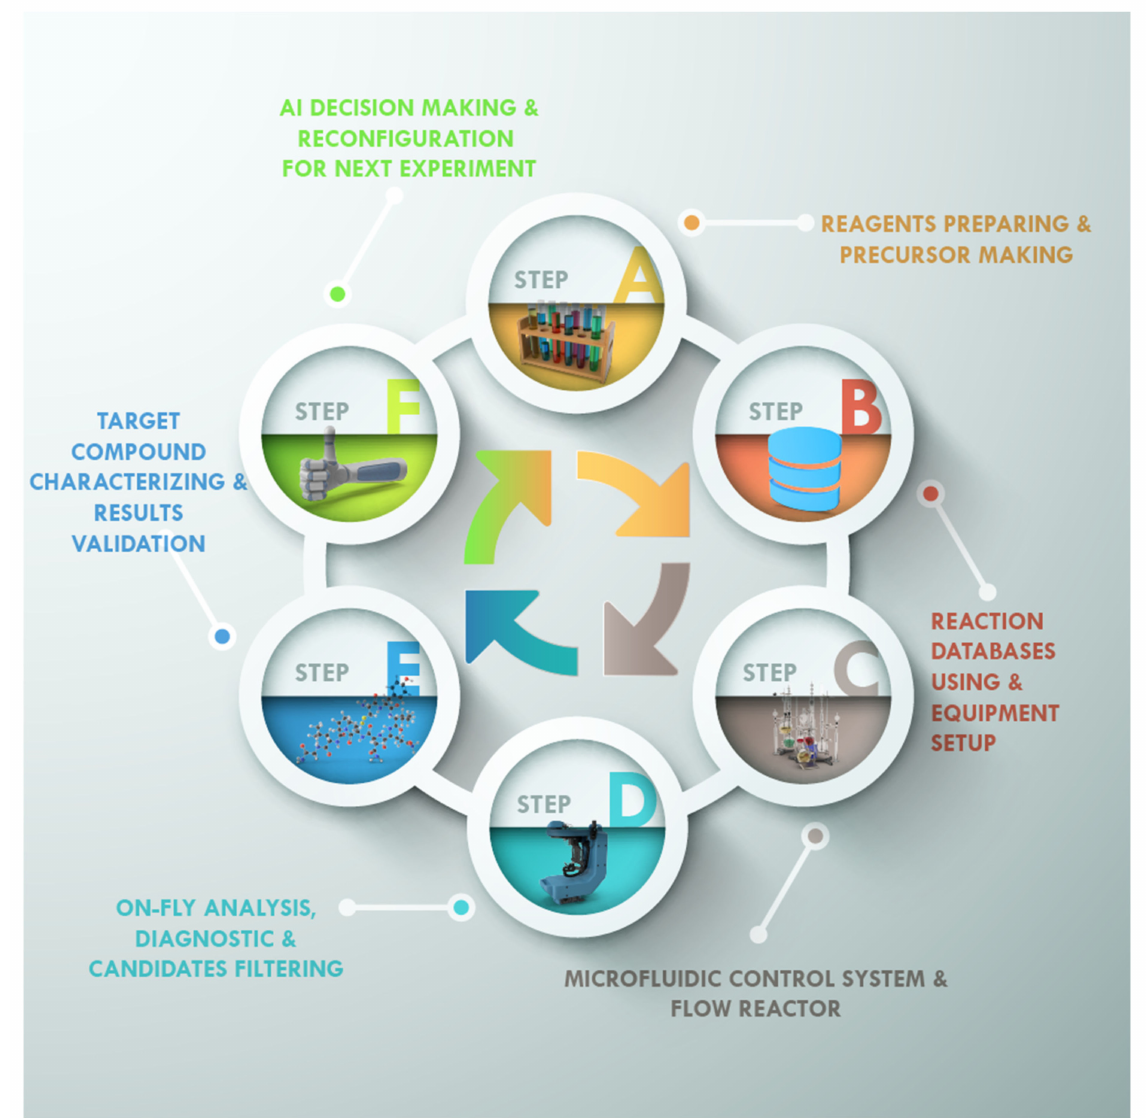
Figure 4. Fully automated closed-loop self-driving